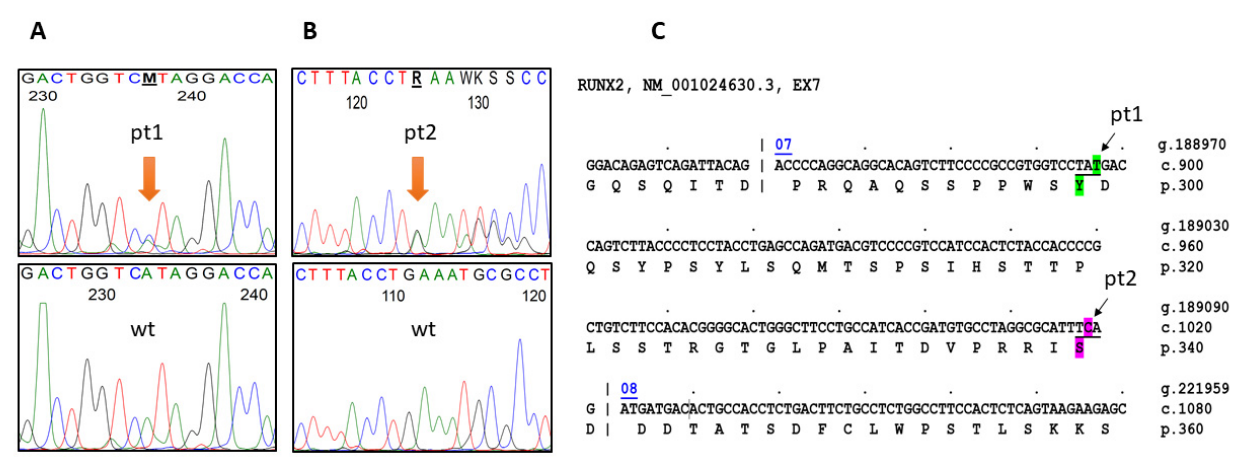
Figure 3. Reverse gDNA sequences of the two novel RUNX2 mutations in CCD patient 1 ( A ) and patient 2 ( B ) with their respective wild-type sequences. The mutations, a c.897T > G transition (Pt1) and a c.1019del of a C nucleotide (Pt2), high- lighted in yellow and purple, respectively ( C ), were confirmed by forward gDNA sequencing.